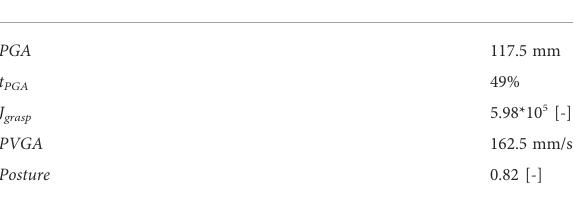
TABLE 2 Computed Indicators regarding ef fi ciency, planning capabilities, smoothness, speed and grasp stability. Indicator